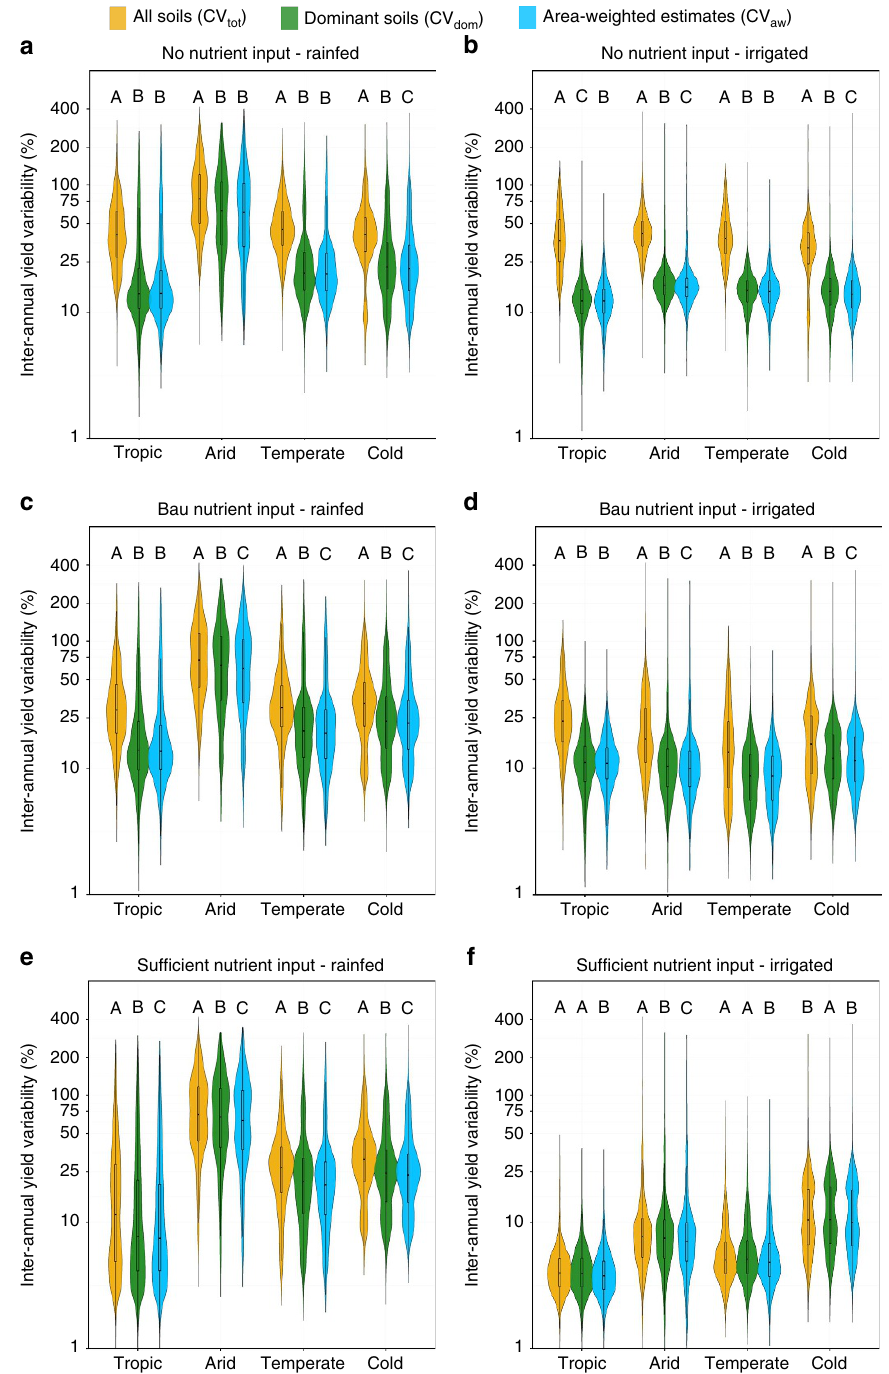
Figure 2 | Violin plots of the coefficient of variation of maize yields for various soil pools and weightings. Coefficients of variation (CV) are shown for all soil types (CV tot ), the dominant soil type only (CV dom ) or the area-weighted CV across all soil types in a grid cell based on each soil’s extent (CV aw ). Each panel shows a nutrient and water management scenario with ( a ) no nutrient application and rainfed water supply, ( b ) no nutrient application and sufficient irrigation water supply, ( c ) business-as-usual (bau) nutrient application and rainfed water supply, ( d ) bau nutrient application and sufficient irrigation water supply, ( e ) sufficient nutrient application and rainfed water supply and ( f ) sufficient nutrient application and sufficient irrigation water supply (see Table 3 for details). The violins represent the density of values along the y axis and are of equal area. The capital letters A–C indicate whether the samples are significantly different according to a Tukey HSD test within each climate region and management scenario. The complete results of statistical analyses are presented in Supplementary Table 2. Grid cells with only one reported soil type, arctic climate or without reported maize harvested area were